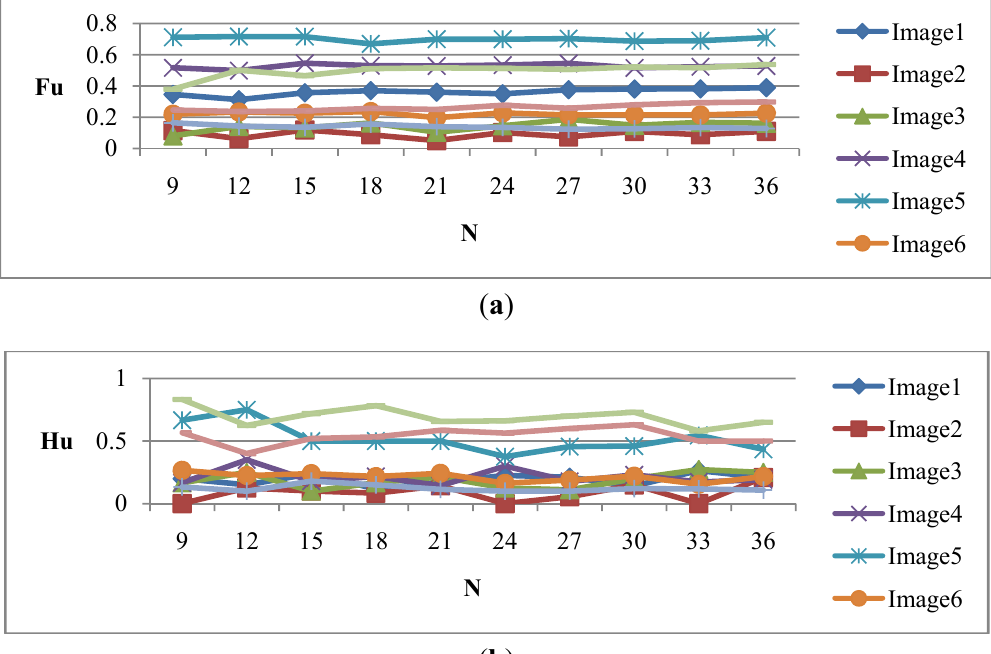
value curves and ( b ) the H Figure 4. ( a ) The F μ with different numbers of checking areas for Figure